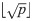
Error rate estimates for the real data null case study with correlations.Shown are different error rate estimates for studies based on six real data sets with correlated predictors and two or three response classes, respectively, of nearly the same size. The error rate was estimated through the test error, the OOB error, the stratified OOB error, the CV error, and the stratified CV error for settings with different sample sizes, n, and numbers of predictors, p. The mean error rate over 1000 repetitions was obtained for a range of mtry values. The vertical grey dashed line in each plot indicates the most commonly used default choice for mtry in classification tasks, that is ⌊p⌋.